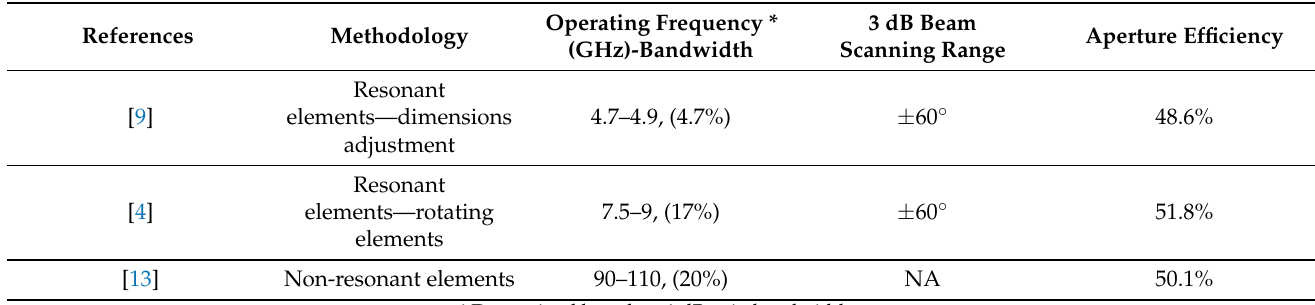
Figure 2. Height-tunable patch antenna unit cell of the RA in [9] with adjustable middle layer. Table 1. Comparative analysis of mechanically reconfigurable RAs using reconfigurable